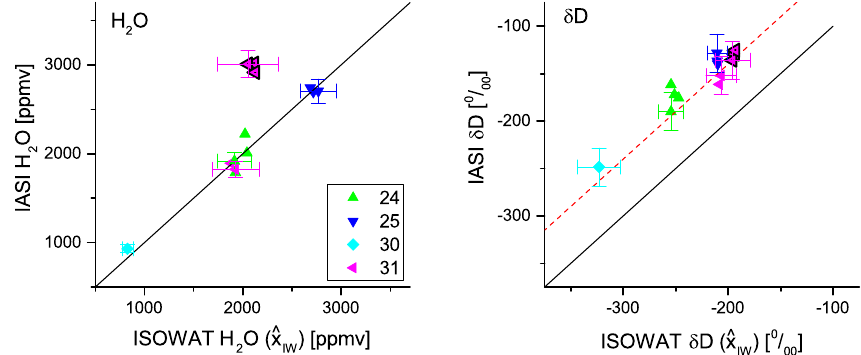
Figure 11. As Fig. 10, but for correlation between ISOWAT data (here smoothed with IASI kernels, i.e. this ISOWAT data are different to the ISOWAT data as depicted in Fig. 10) and IASI data for 5km altitude. Three H 2 O outliers on day 130731 (blue triangles) are marked by black edges. For clarity the error bars are only given for one observation per day and on day 130731 in addition for one of the three outliers.